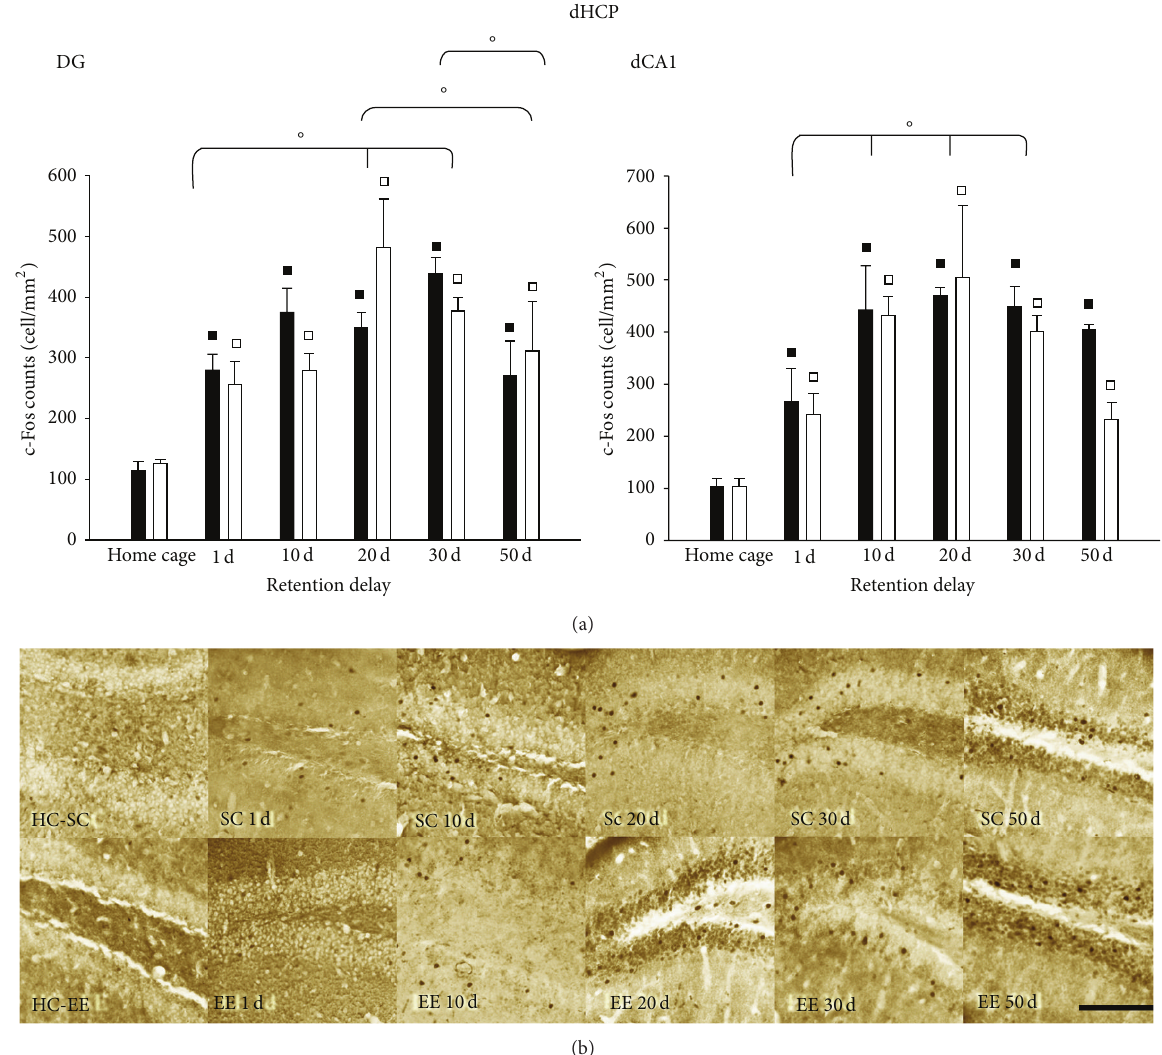
Figure 2: (a) c-Fos expression in subregions of dHPC for EE (open columns) and SC (filled columns) mice subjected to recall probe tests at 1, 10, 20, 30, and 50 days. DG : two-way ANOVA post hoc analysis Holm-Sidak method, SC versus EE, 𝑃 = 0.968 ; HC-SC versus HC-EE, 𝑃 = 0.503 ; SC versus HC-SC and EE versus HC-EE 𝑃 < 0.05 for all retention intervals. Statistical differences for factor day were found between 1 and 20 days, 1 and 30 days, and 50 days versus 20 and 30 days, all 𝑃 < 0.05 . dCA1 : two-way ANOVA post hoc analysis Holm-Sidak method, SC versus EE, 𝑃 = 0.242 ; HC-SC versus HC-EE 𝑃 = 0.979 . Statistical difference factor day were found between 1 and 10, 20 and 30 days, all 𝑃 < 0.05 . ◼ Statistical significance between EE and HC-EE; ◻ statistical significance between SC and HC-SC; ∘ statistical significance for factor day; error bars = s.e.m. (b) Representative panel of c-Fos protein expression in DG for EE and SC animals, for all recall probe tests; scale bar 100 𝜇